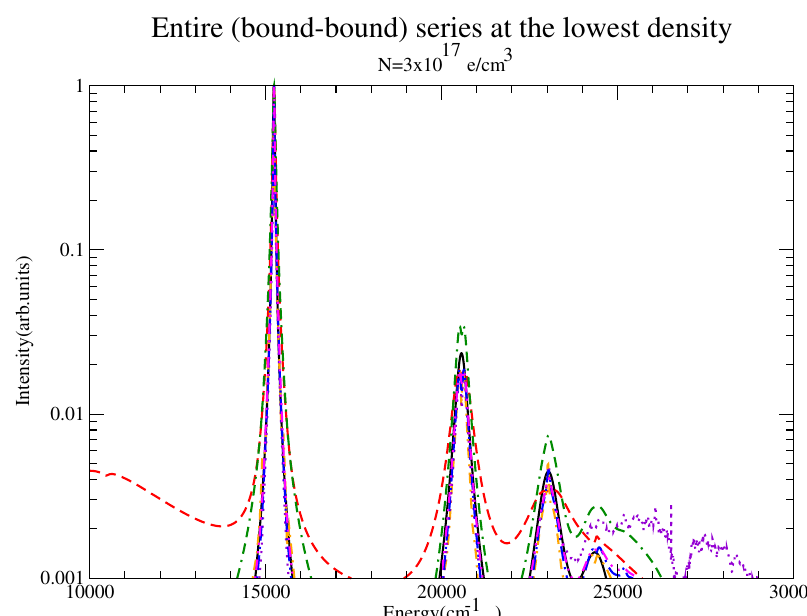
Figure 8. The entire series for the lowest density considered for QC-FFM (solid black), PPP (dashed red), DWE (dash-dotted orange), CONVST without strong collisions (dotted violet), CONVST with strong collisions (dot-double dashed green), CONVPST without strong collisions (long dash-dotted blue) and CONVPST with strong collisions (dash-double dotted magenta).